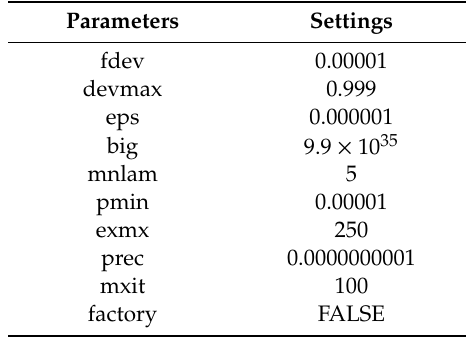
Table 3. Logistic regression approach—parameter